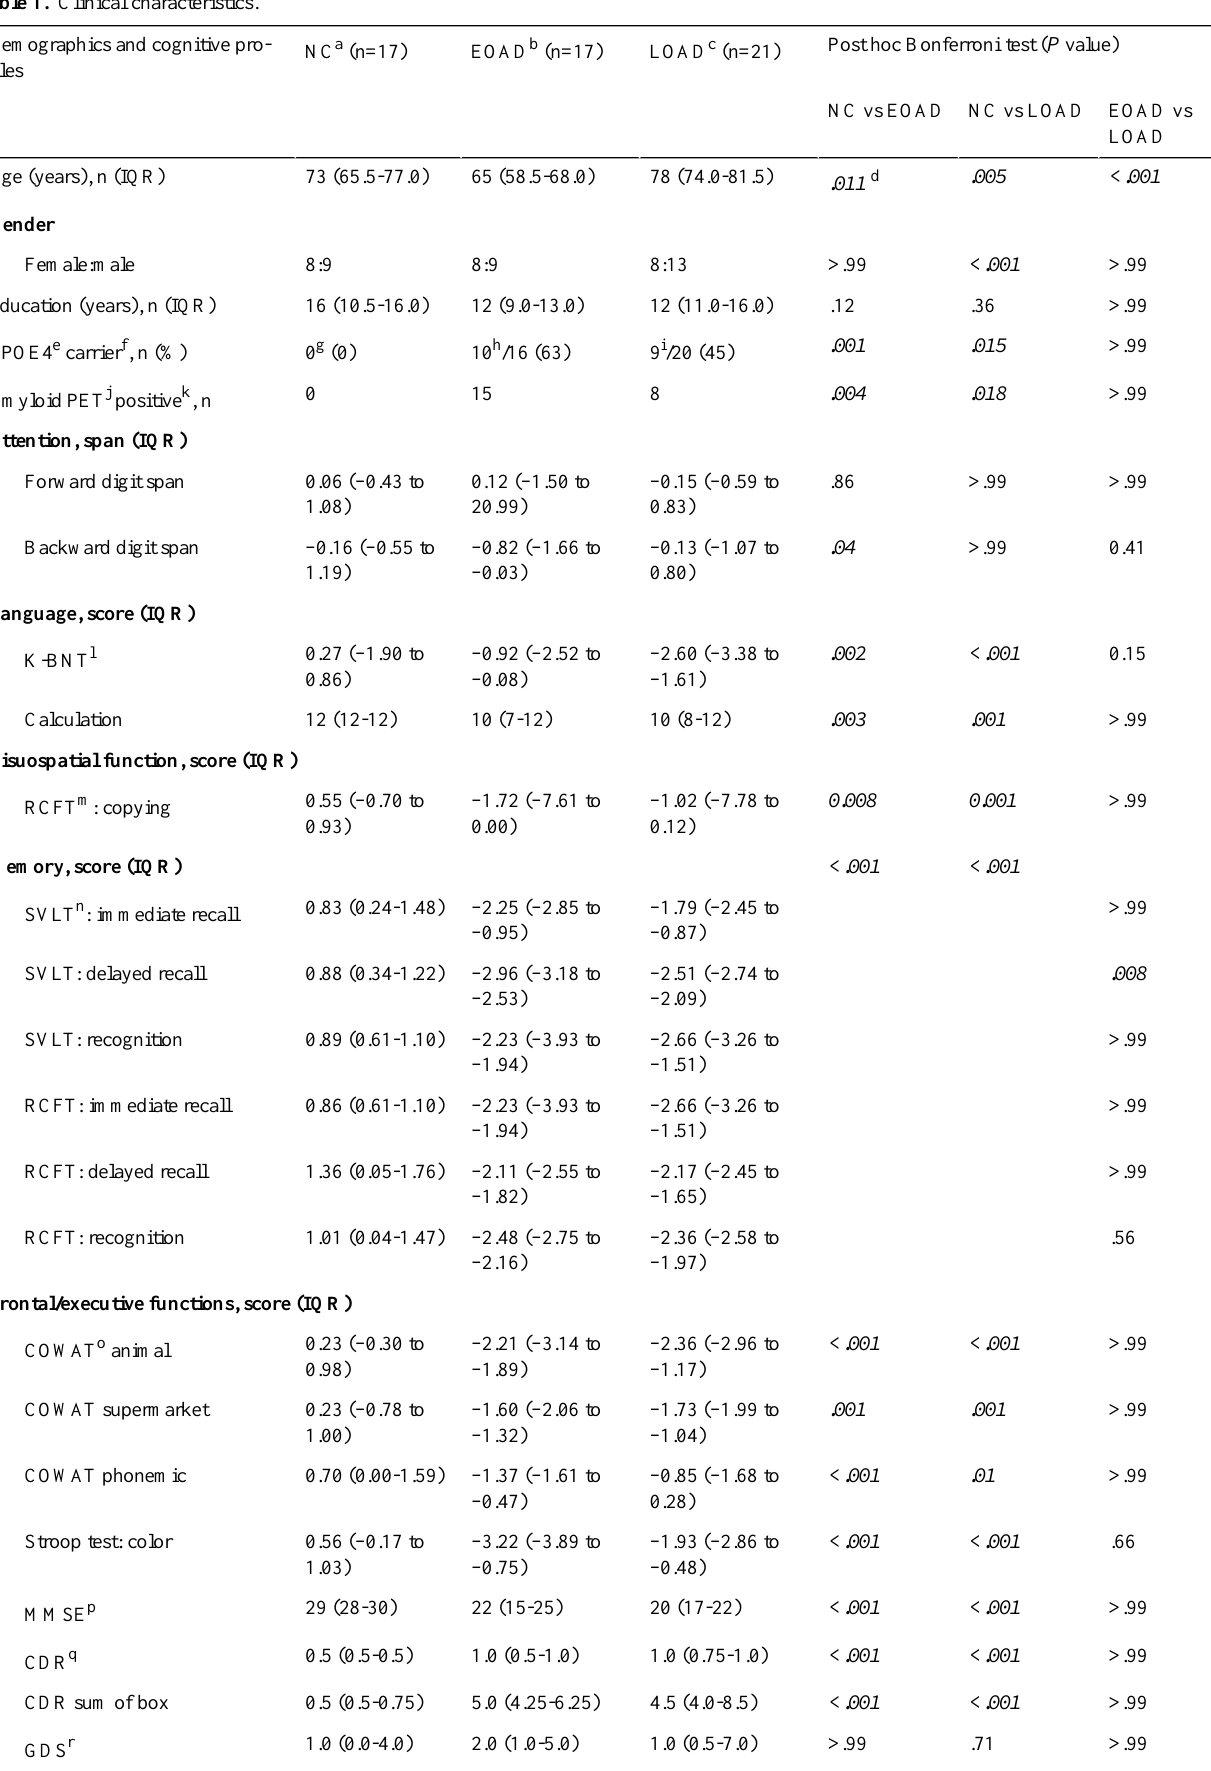
Table 1. Clinical